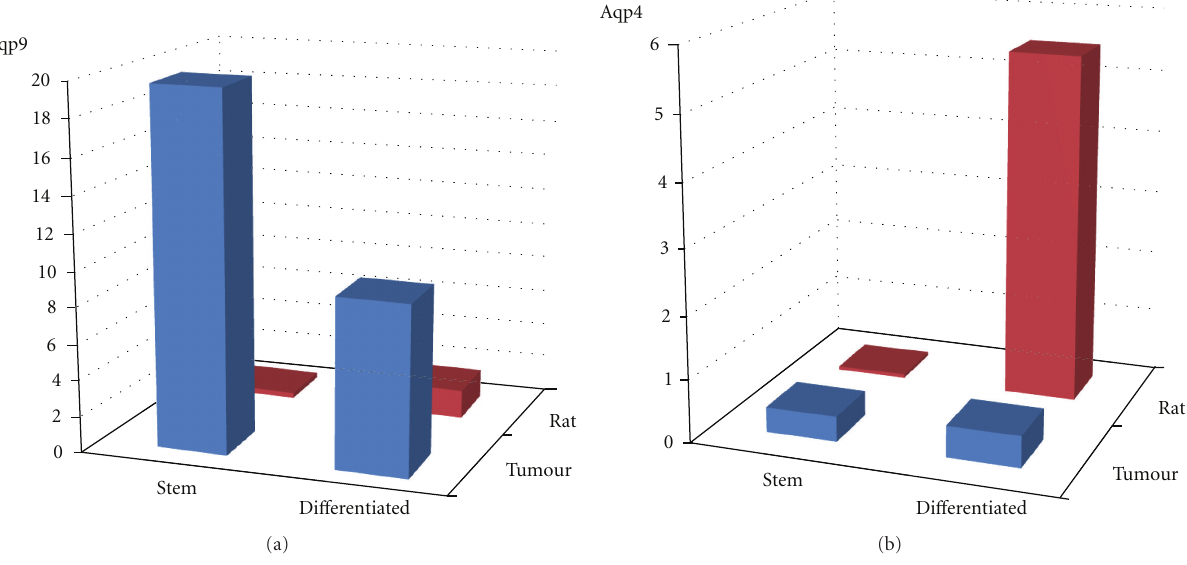
Figure 2: Distinctive behaviour of aqp9. Normal expression exhibited by rat progenitors and di ff erentiated derivatives can be compared to that of tumour stem cells and derivatives. Whilst aqp4 expression does not markedly increase from tumour progenitor to di ff erentiated cell, its expression increases markedly in rat di ff erentiated cells. The situation for aqp9 is clearly di ff erent. Aqp9 is highly increased in both progenitor and di ff erentiated derivatives when compared to normal rat tissue-derived cells.